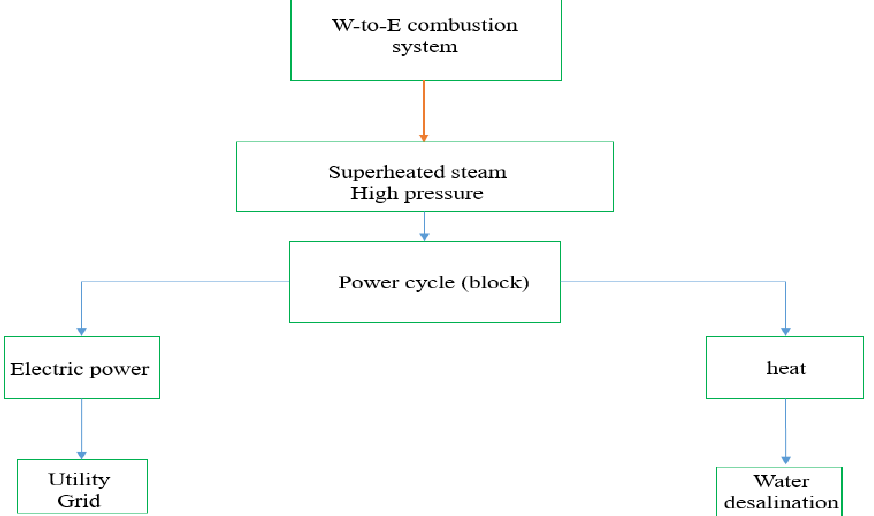
Figure 4. Flowchart of the simulated power plant for waste incineration to produce power and potable water (W-to-W: waste to water by using heat in the multi-stage flash (MSF) process).